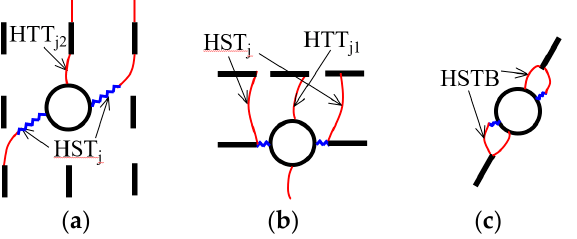
Figure 8. Observed collapse modes of the hole. ( a ) Mode I h; ( b ) Mode II h; ( c ) Mode III h . The collapse modes of all jointed specimens with a hole are listed in Table 3. Collapse